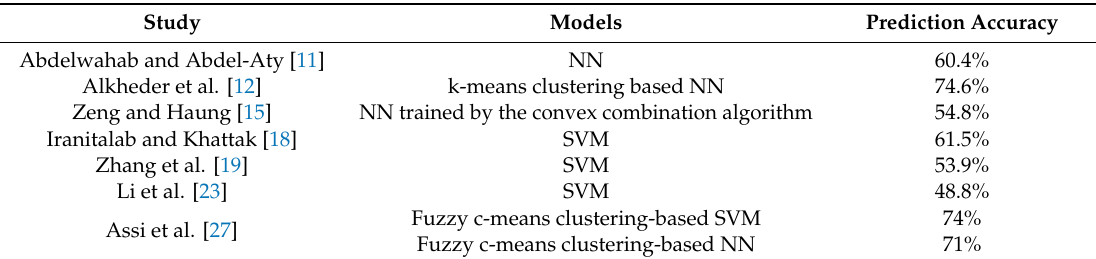
Table 5. Findings of previous